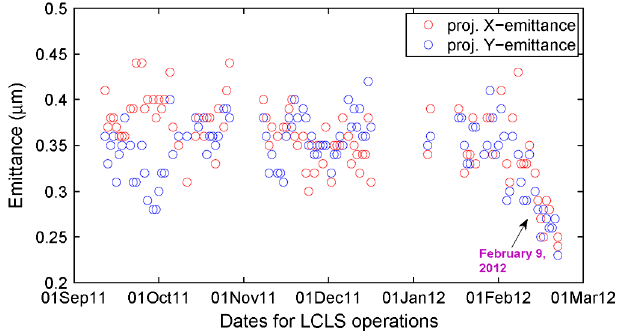
FIG. 7. The LCLS injector emittance (150 pC) evolution dur- ing regular user operations for six months. Emittance of nearly uniform laser spatial (before February 9) and truncated-Gaussian profiles (after February